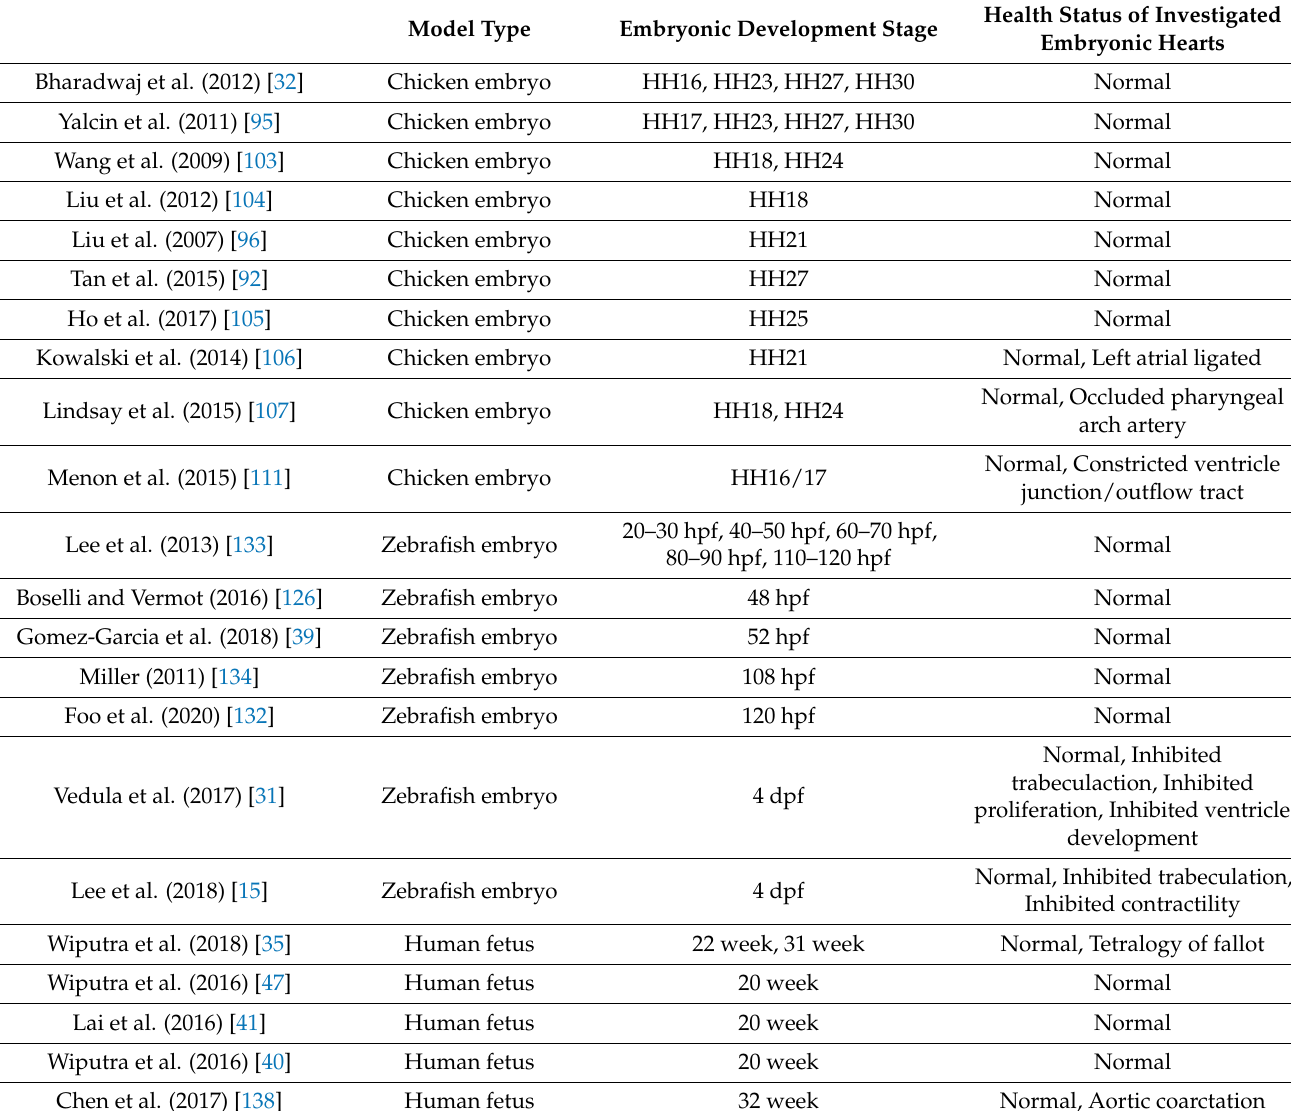
Table 4. Summary of CFD studies presented in this